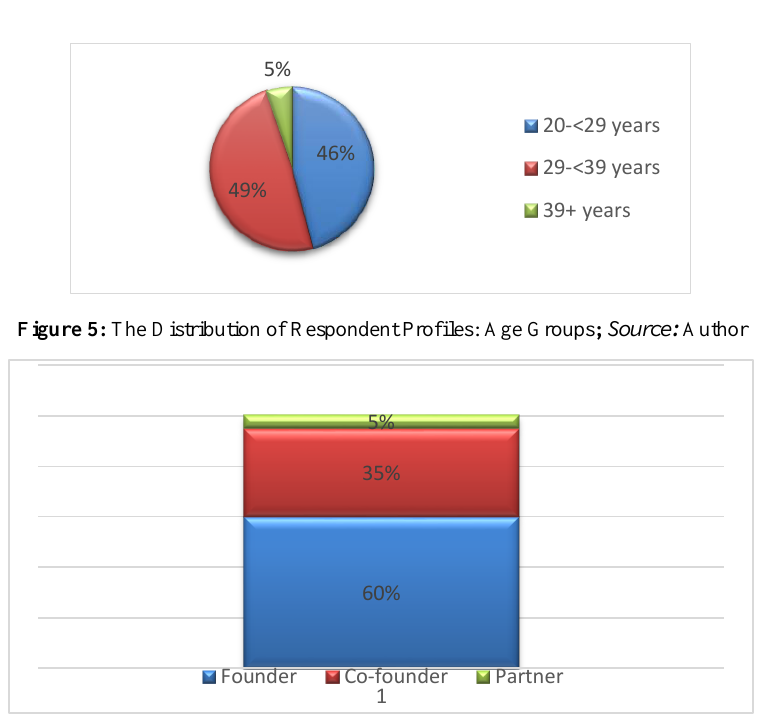
Figure 6: The Distribution of Respondent Profiles: Position ; Source: Author